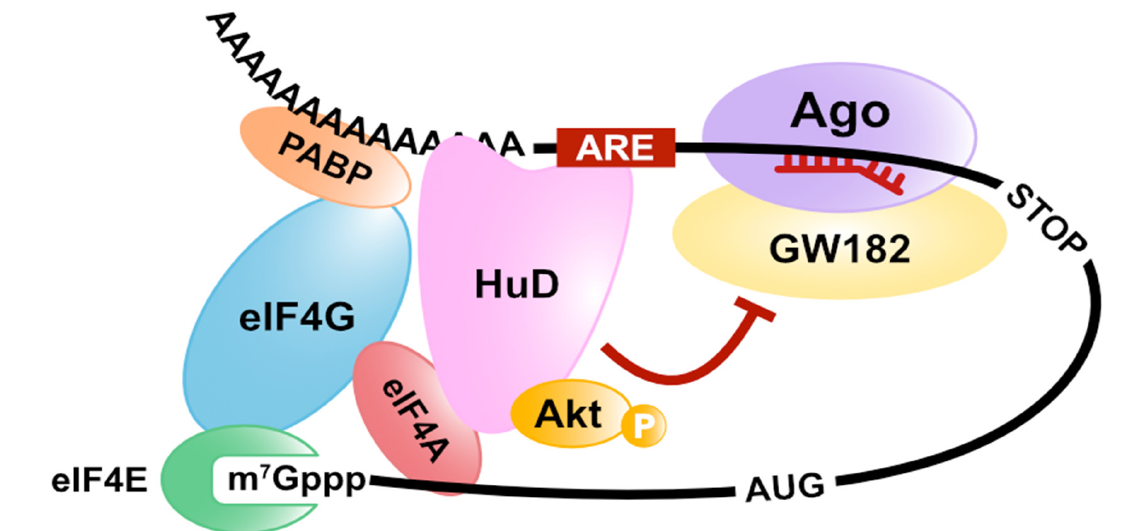
Figure 5. HuD-mediated translation stimulation and miRNA inhibition. HuD interacts with the basic cap-binding complex via the binding to eIF4A and poly(A)-tail and inhibits miRNA-mediated translation repression through the eIF4A-binding.